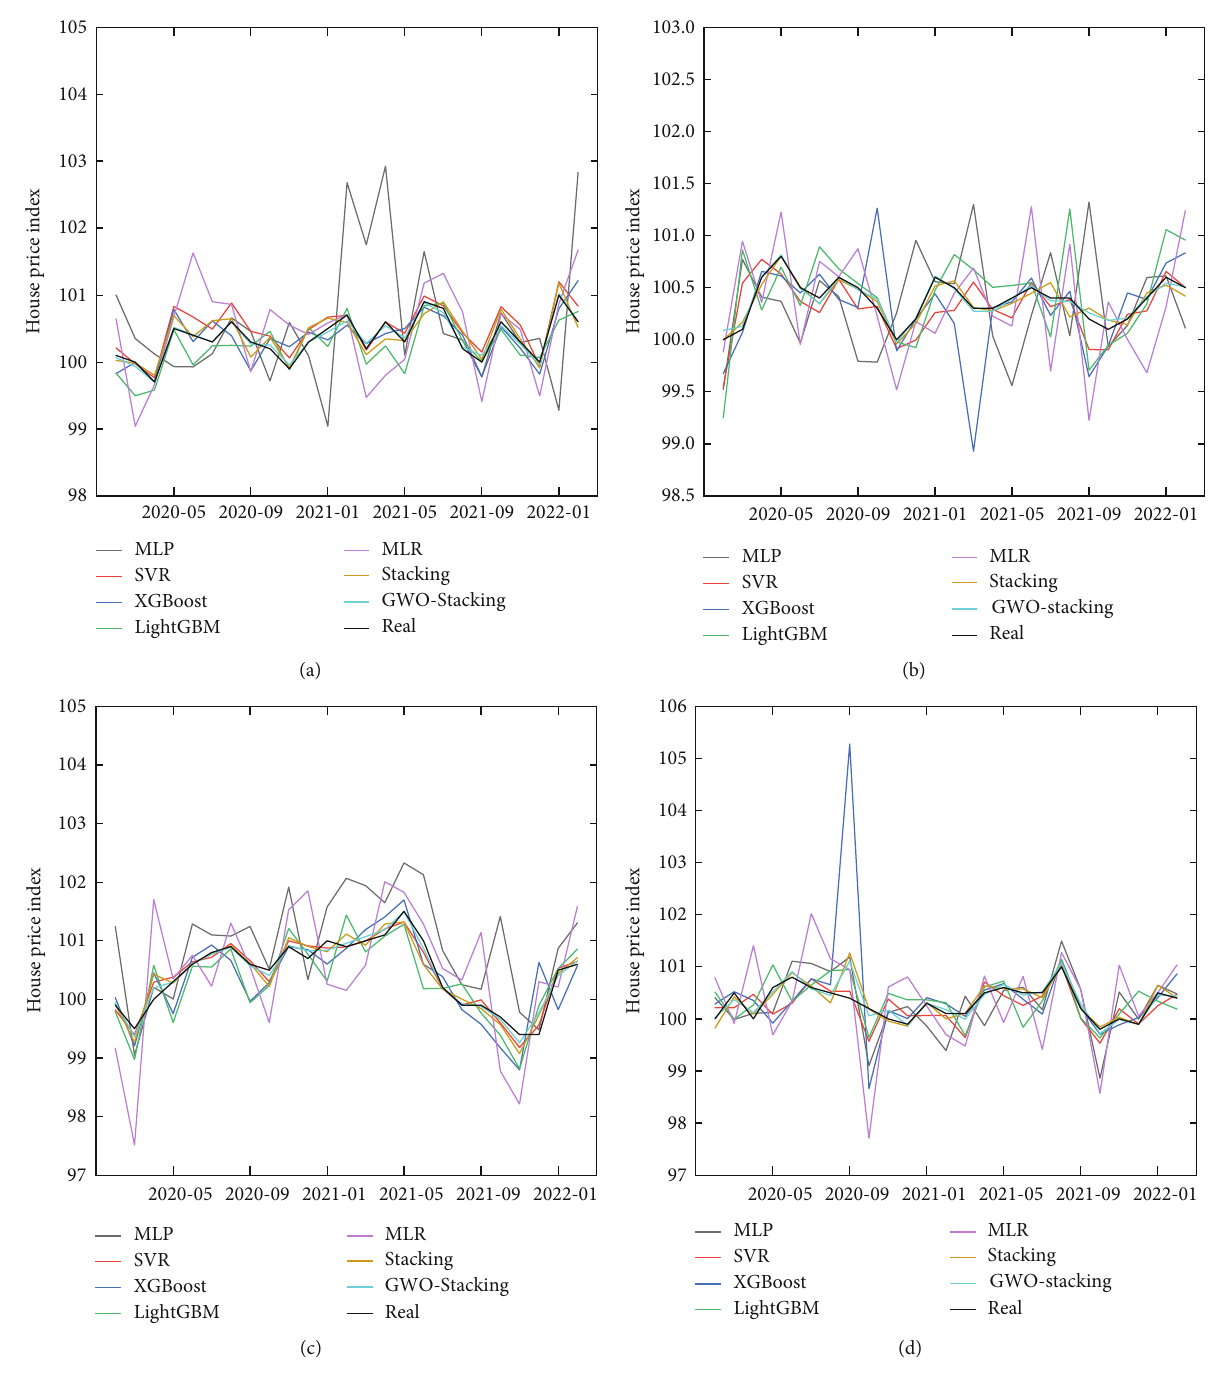
Figure 4: The e ff ect of di ff erent model predictions for four